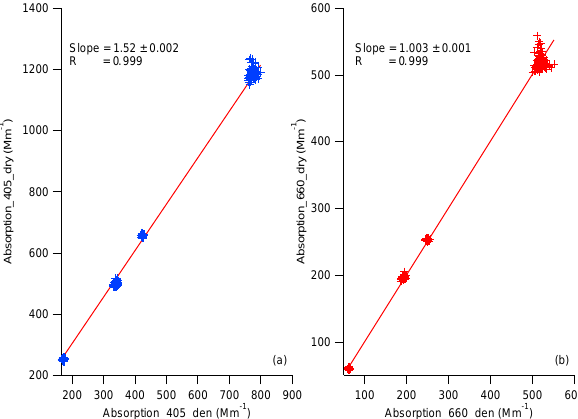
Figure 2. Particles loss through the thermal denuder as a function of particle size and thermal denuder temperature. Figure 3. Comparison of absorption coefficients measured by dry